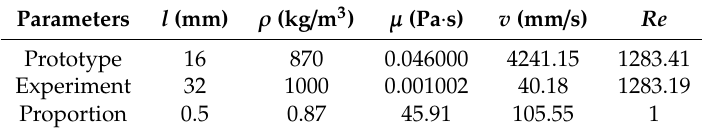
Table 1. The fluid parameters of the prototype and experimental